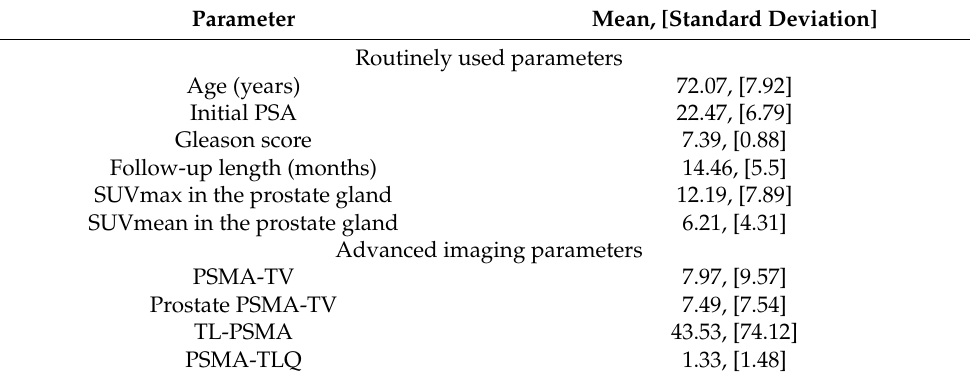
Table 1. Descriptive statistics of the cohort ( n = 85).